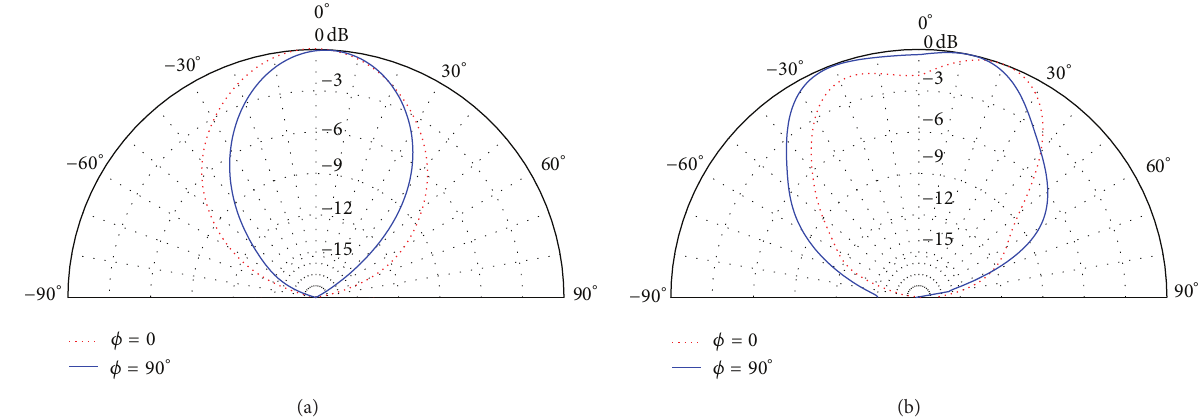
Figure 6: Simulated radiation patterns of spiral antenna at 566MHz (a) and at 716MHz (b).